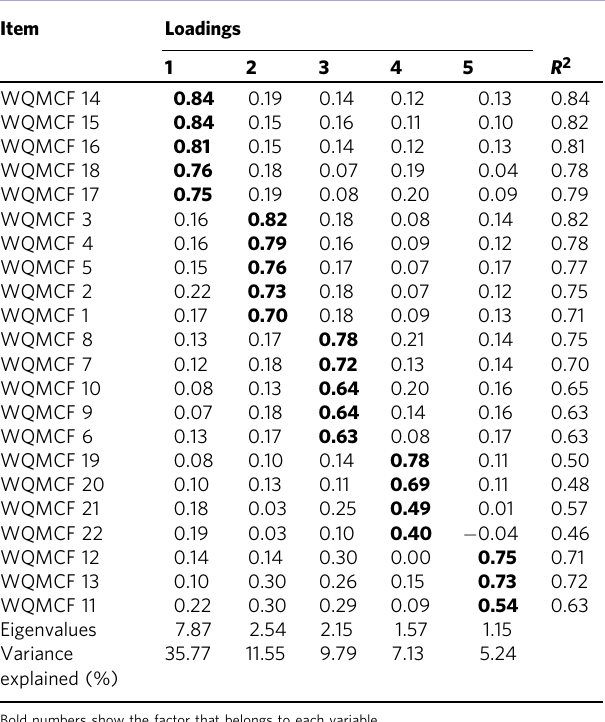
Table 3 Loadings and item-total correlation (r) of items for each extracted